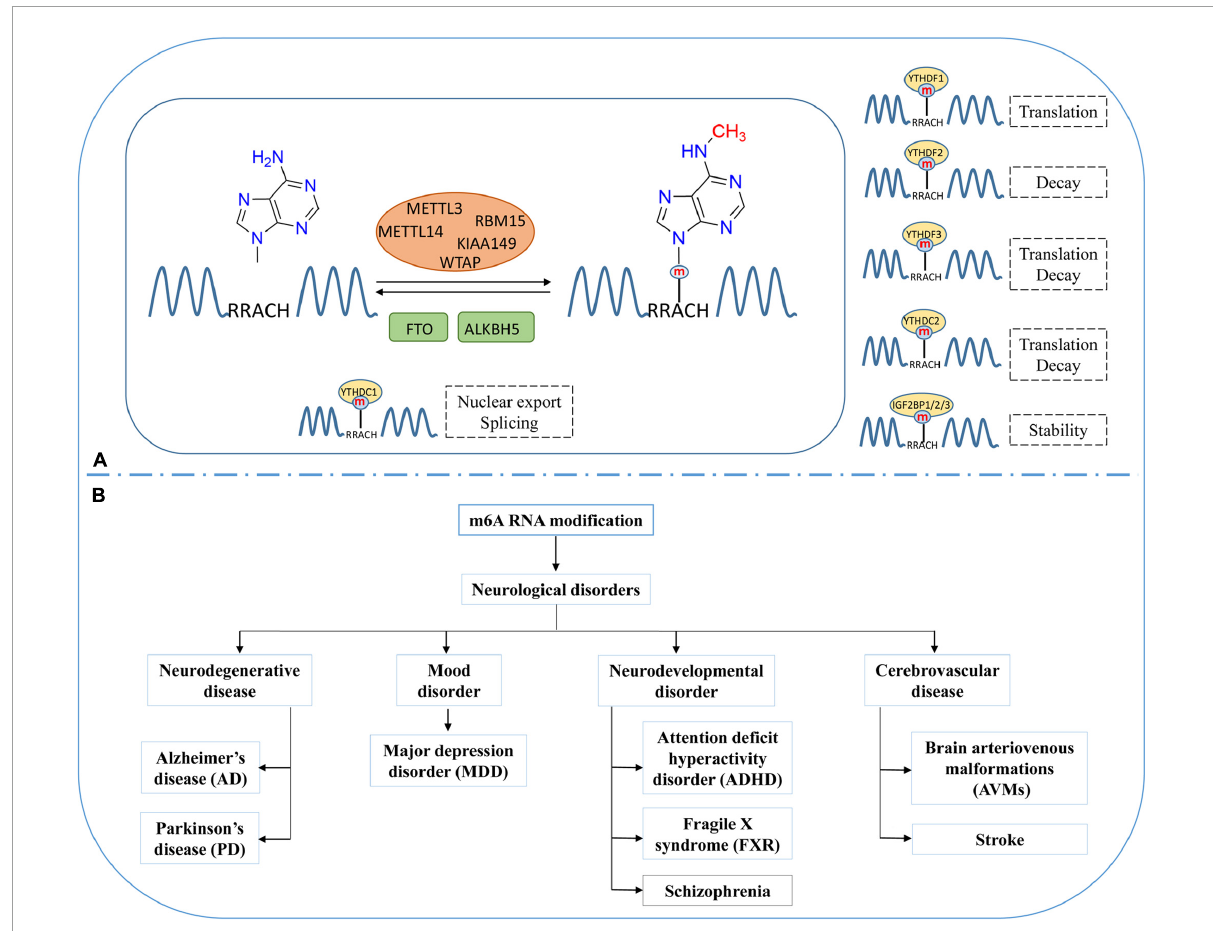
FIGURE1 Dynamic and reversible regulation of m6A RNA modification and its role in neurological disorders. (A) Regulation of m6A modification by methyltransferases (METTL3, METTL14), demethylases (FTO and ALKBH5) and the effects of m6A modification on the processing, splicing, stability, and translation of mRNA. (B) Various neurological disorders regulated by m6A RNA